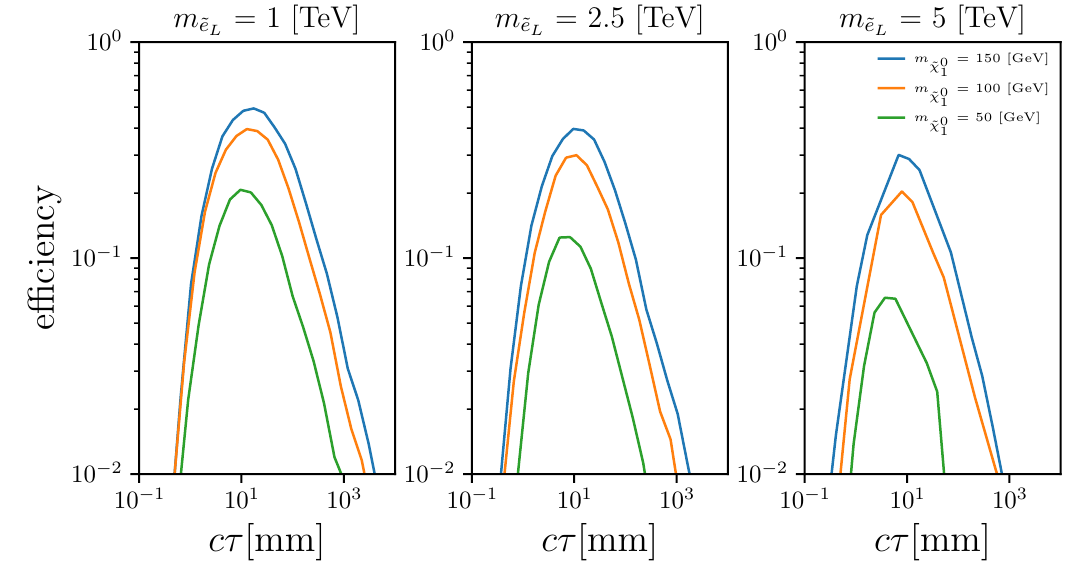
Figure 4 . DV selection efficiency as a function of the c τ of the neutralino, for three fixed slepton masses and three fixed values of the neutralino